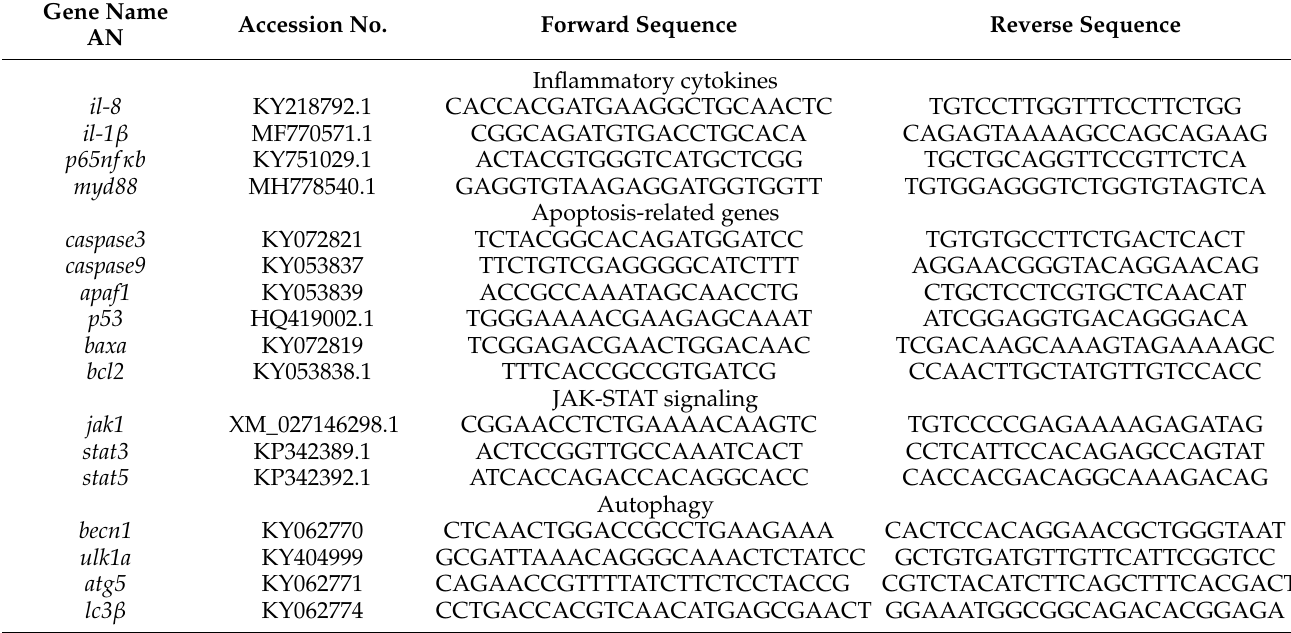
Table 2. Primer used in the present